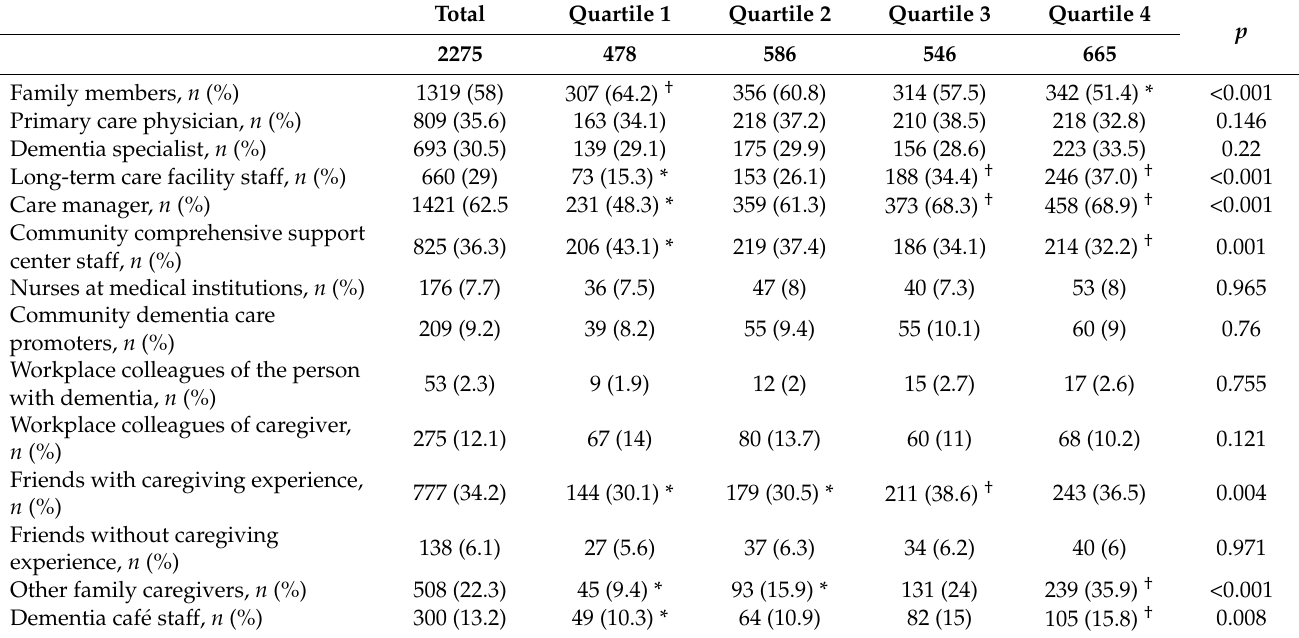
Table 4. Persons consulted at the time of diagnosis of dementia and